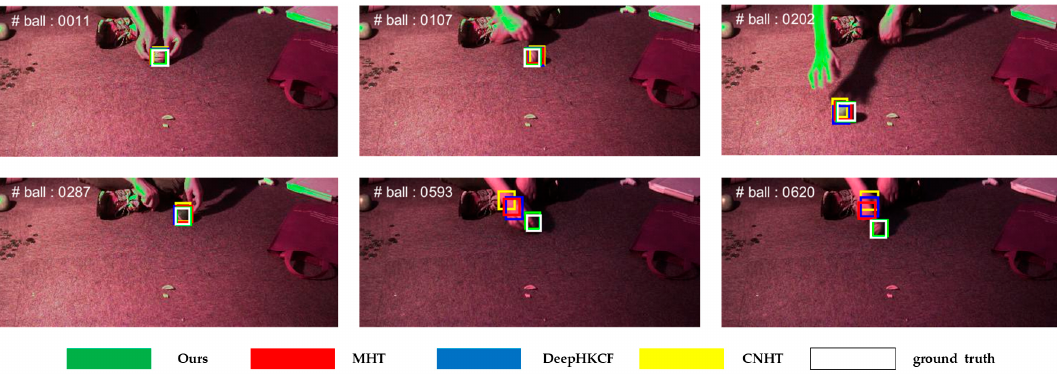
Figure 8. Tracking result of the ball sequence.